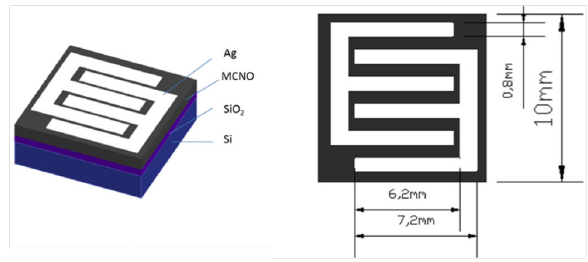
Fig. 1 Overall structure and plane diagram of MCNO thin film.